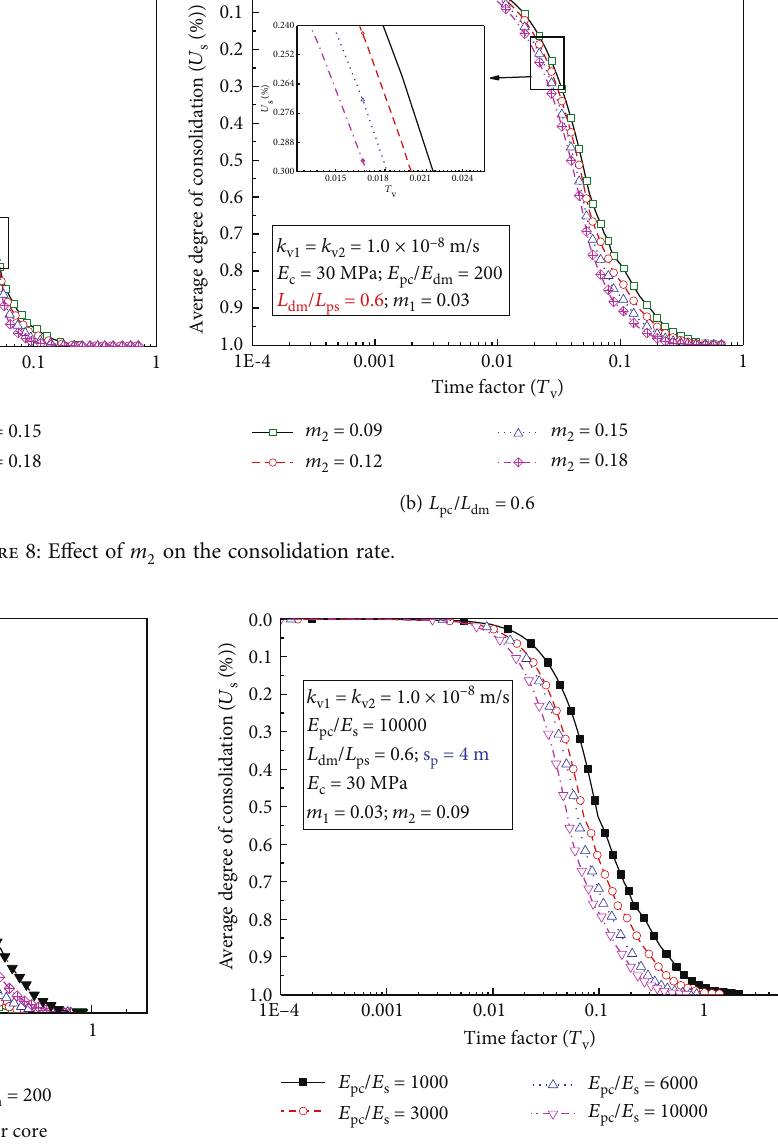
/ E on the consolidation pc s